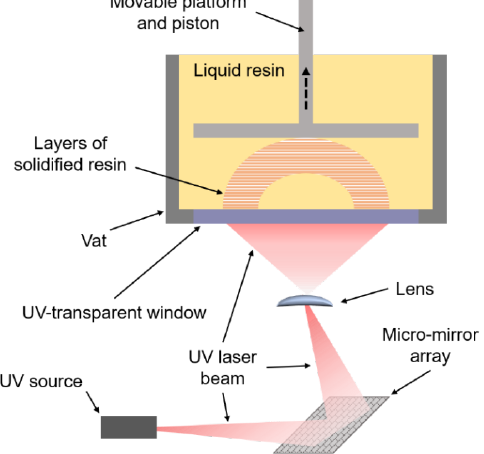
Figure 5. Schematic of a typical DLP printing method.